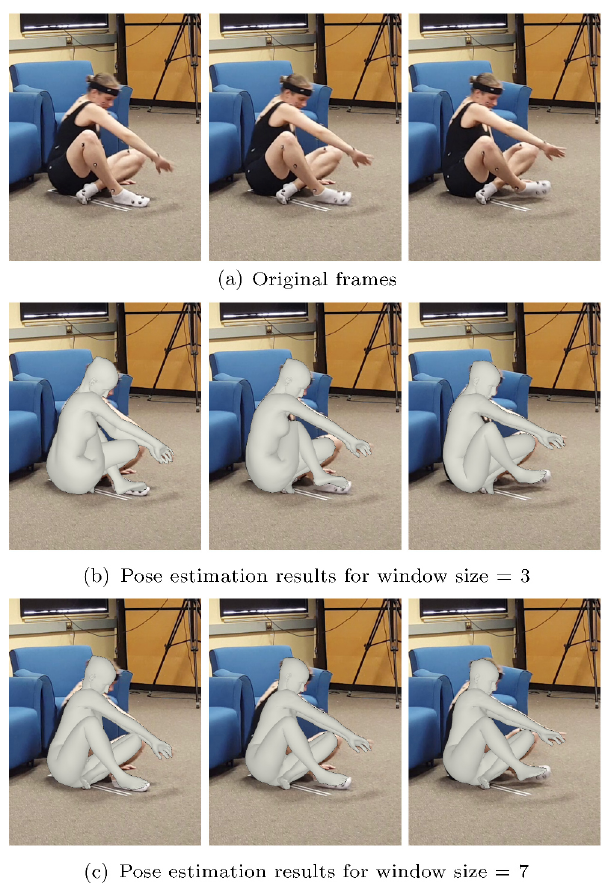
Fig. 11 Subject 16 from MoVi performing Complex Motion (standing up from a cross-legged position) for window sizes 3 and 7. While a small window (size = 3) does not sufficiently approximate the objective function in 6 and leads to unstable results, a slightly larger window (size = 7) leads to temporally stable and robust